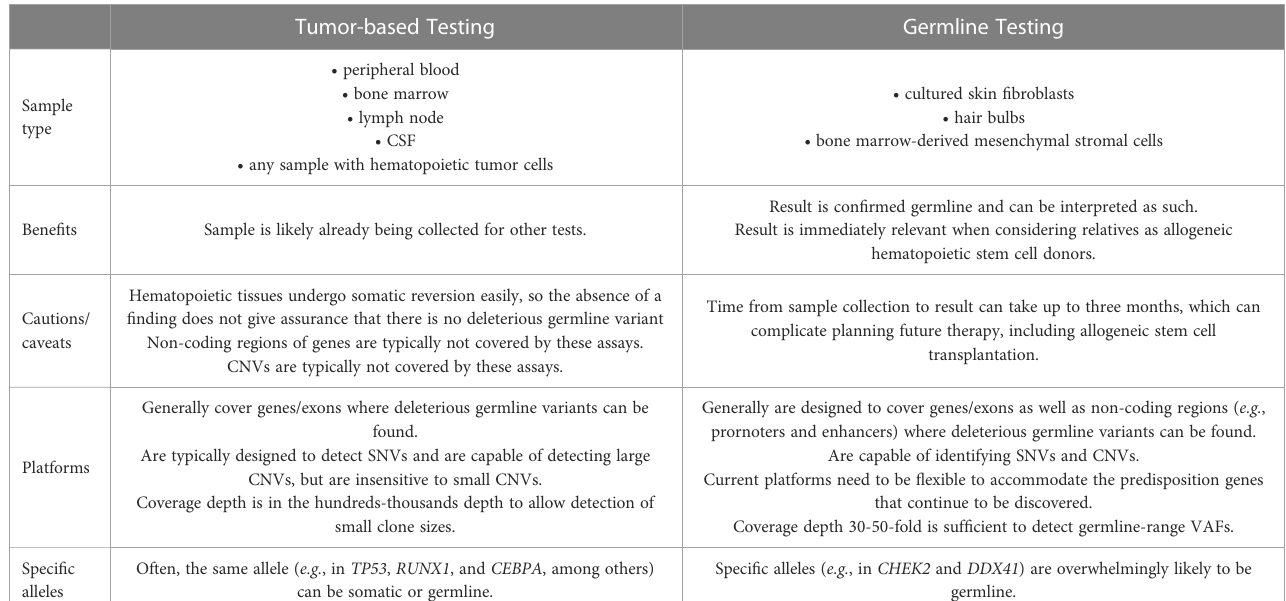
TABLE 2 Contrasting tumor-based versus germline